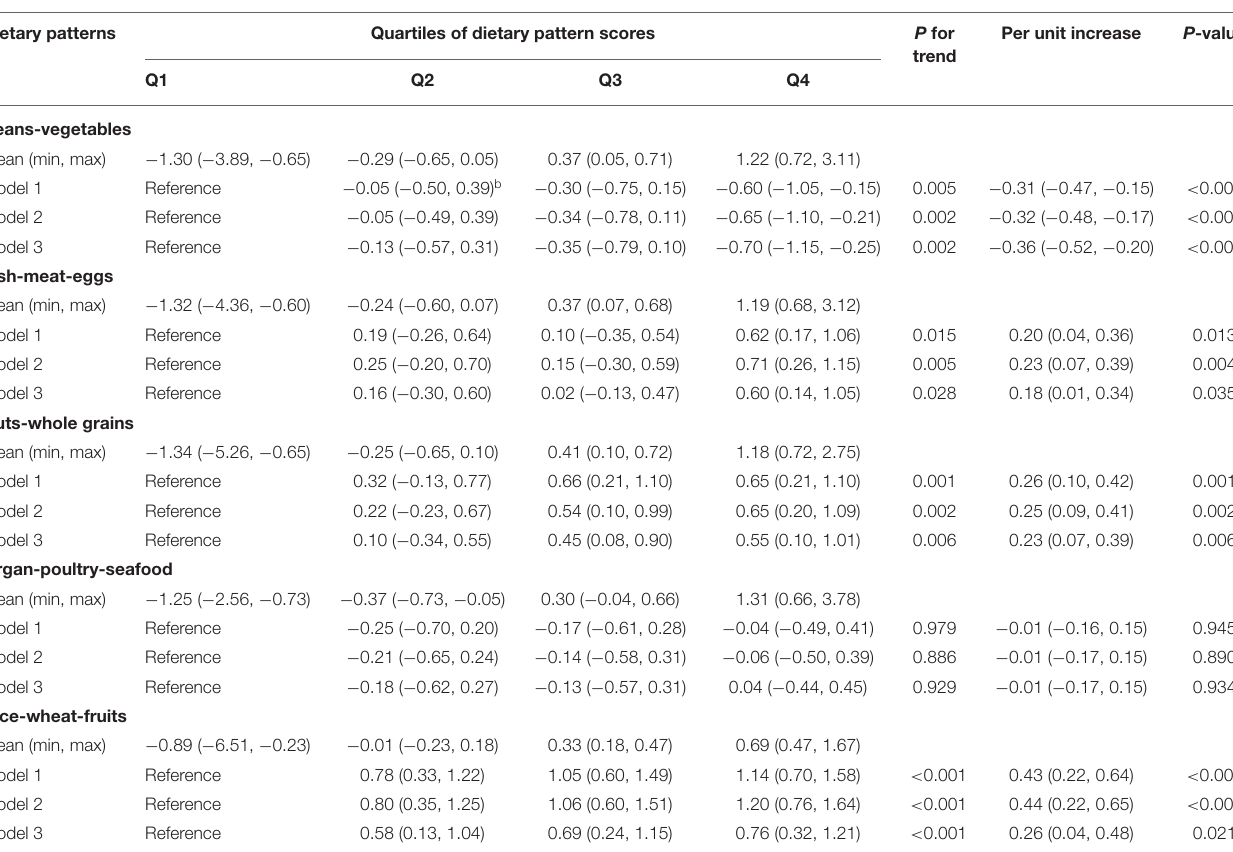
a Multivariate linear regression models were as followed: Model 1, crude model; Model 2, adjusted for other four dietary patterns; Model 3, adjusted for Model 2 + maternal age, physical activity, ethnology, maternal education, average personal income, family history of diabetes, family history of obesity, smoking habit, alcohol habit, parity, pre-pregnancy BMI, GDM, and total energy intake. b Values were presented as β (95% CI) (all such